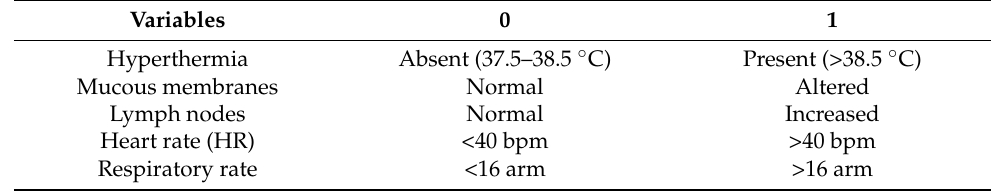
Table 1. Scoring system used during clinical evaluations of the horses included in the study. Variables 0 1 Hyperthermia Absent (37.5–38.5 ◦ C) Present (>38.5 ◦ C) Mucous membranes Normal Altered Lymph nodes Normal Increased Heart rate (HR) <40 bpm >40 bpm Respiratory rate <16 arm >16